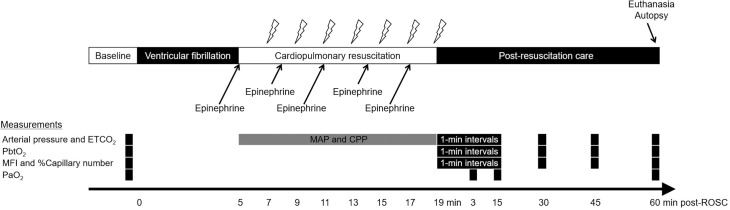
Experimental timeline.After 5 min of untreated ventricular fibrillation, cardiopulmonary resuscitation was initiated using a mechanical chest compression device. The lightning marks indicate the onset of a 10-s pause in chest compression for rhythm analysis and a 150-J electric shock, if indicated. After ROSC, the animals were observed for 60 min in a simulated intensive care setting. Arterial pressure, ETCO2, MFI, %Capillary number, and PbtO2 were sampled at pre-arrest baseline, 1-min intervals for 15 min after ROSC, and 30, 45, and 60 min after ROSC. Arterial blood gases were measured at pre-arrest baseline and 3, 15, and 60 min after ROSC. MAP and CPP during cardiopulmonary resuscitation were sampled 2 min after the initiation of cardiopulmonary resuscitation since most of the animals (80%) achieved ROSC 2–4 min after cardiopulmonary resuscitation. ETCO2, end-tidal carbon dioxide; PbtO2, brain tissue oxygen tension, MFI, microvascular flow index; %Capillary number, percent of counted number of perfused capillaries relative to that at pre-arrest baseline; PaO2, partial pressure of oxygen in arterial blood; MAP, mean arterial pressure; CPP, coronary perfusion pressure; ROSC, restoration of spontaneous circulation.